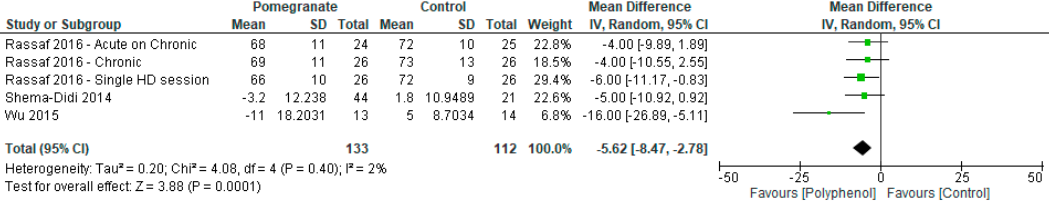
Figure 3. Forest plot of polyphenol-rich interventions on diastolic blood pressure.